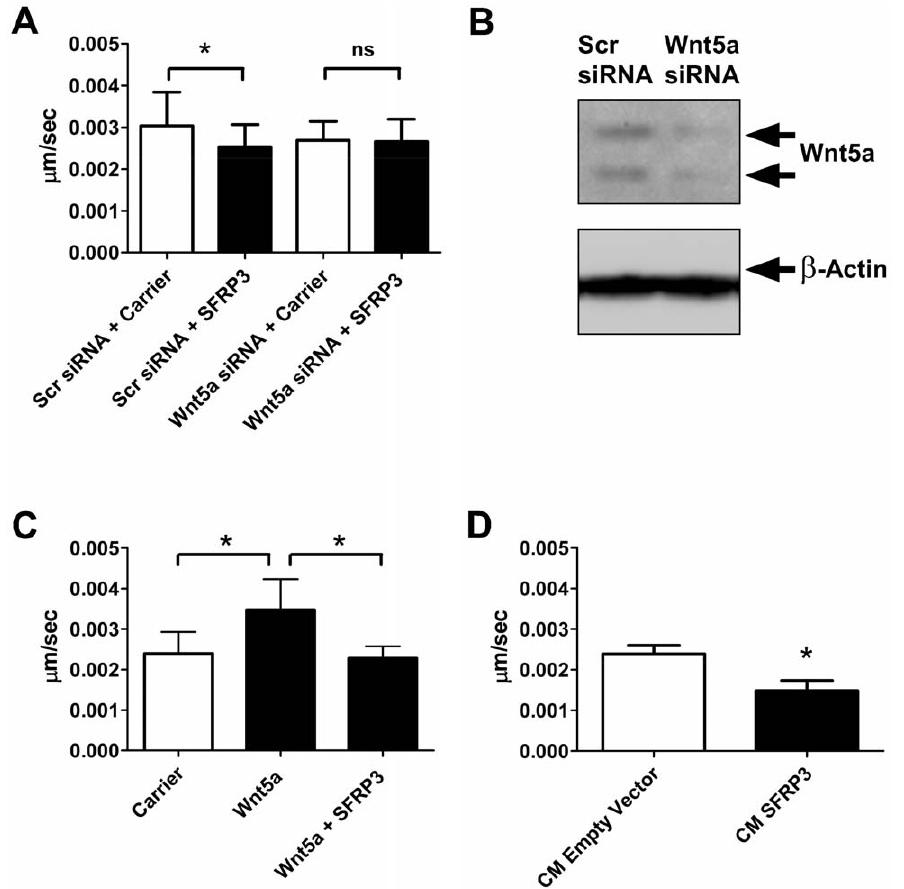
Figure 5. SFRP3 inhibits migration in melanoma cells by antagonizing Wnt5a. A , Migration assay using Wnt5a knockdown cells. siRNA transfected A2058 cells were grown in serum-free media for 24 h and then treated with 1 m g/ml rSFRP3 or carrier. Migration was analyzed using time- lapse microscopy for 24 h. The error bars represent SD, (n=4). B , Wnt5a knockdown. The knockdown of Wnt5a in A2058 cells were analyzed using western blot but also by RT-PCR (Figure S4). C , Migration assay using rWnt5a and rSFRP3 in A2058 cells. Cells were pre-treated with either carrier or 1 m g/ml rSFRP3 in serum-free media for 24 h. The cells were then treated with rWnt5a 0.2 m g/ml and analyzed using time-lapse microscopy as in A for 24 h. The error bars represent SD, (n=4). D , SFRP3 conditioned medium and migration assay. HTB63 cells were transfected with pCMV6-Empty-Vector or pCMV6-SFRP3 and kept in serum-free media for 24 h. These media were transferred to non-transfected HTB63 cells that were then analyzed using time-lapse microscopy as in A. Error bars represent SD (n=3). *=p ,